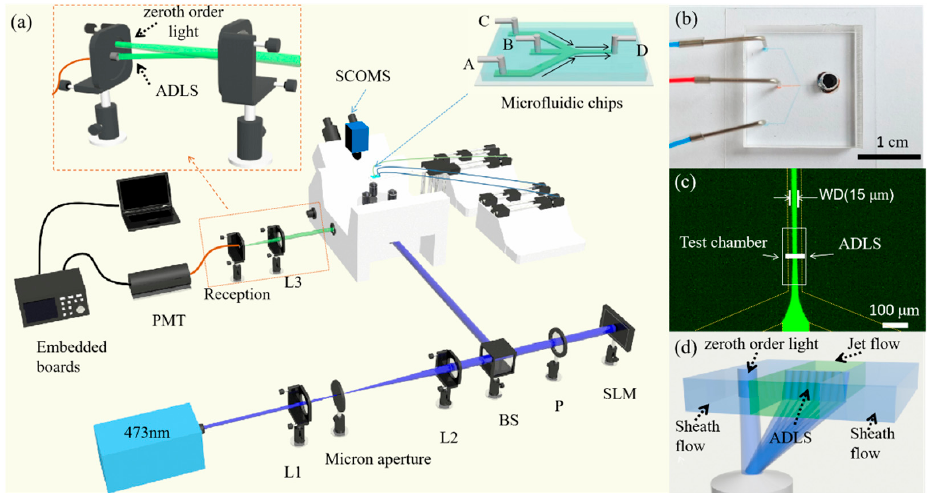
Figure 2. Schematic diagram of the ADLSFC system. ( a ) Schematic of the system. ( b ) Photo of the microfluidic chip. ( c ) Fluorescence image of the microchannel. The inlets A and C are injected with pure water, and B is injected with fluorescein sodium salt solution. All inlets have flow rates of 1 μL/h . The width of the jet (WD) is 15 μm . D is the outlet . ( d ) Schematic diagram of the ADLS in the test chamber after focusing by the objective lens. Zeroth order light spot is separated with the